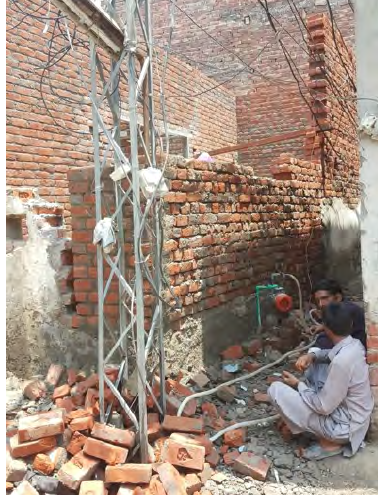
Figure 5. Incremental House construction in Badar Colony, Source: